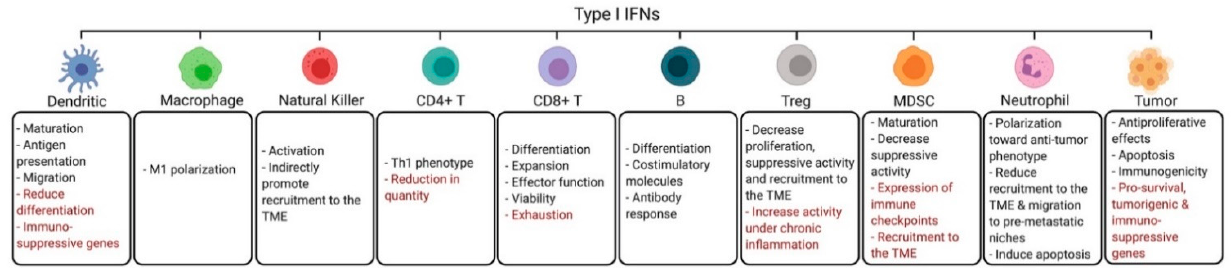
Figure 1. Effects of type I interferons (IFNIs) on malignant cells and cells of the immune system. Exposure to type I IFNs alters the function of target cells within the tumor microenvironment (TME) in ways that promote anti-tumor effects (black) or counter such effects (red).